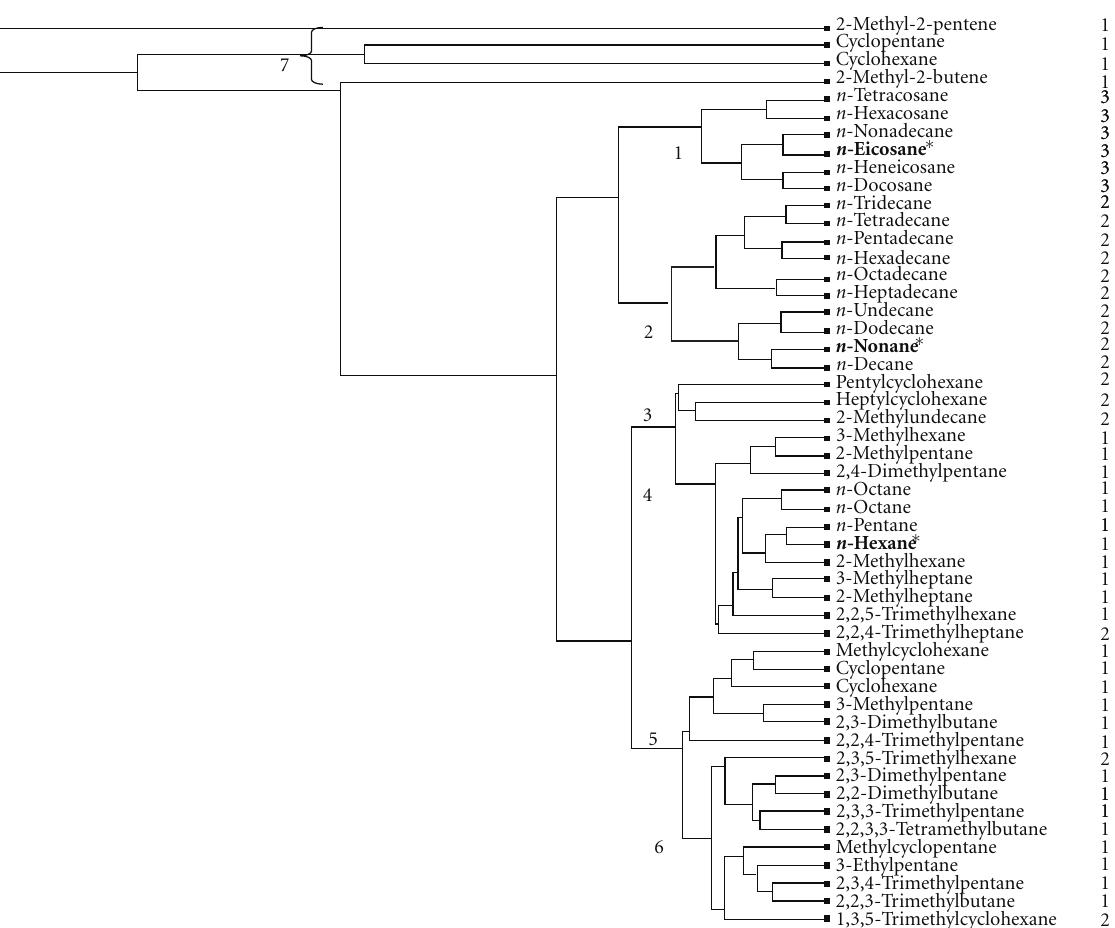
Figure 2: Hierarchical cluster analysis based on CoMFA for all aliphatic fractions. Surrogate chemicals proposed by MADEP [3] are shown in bold and with